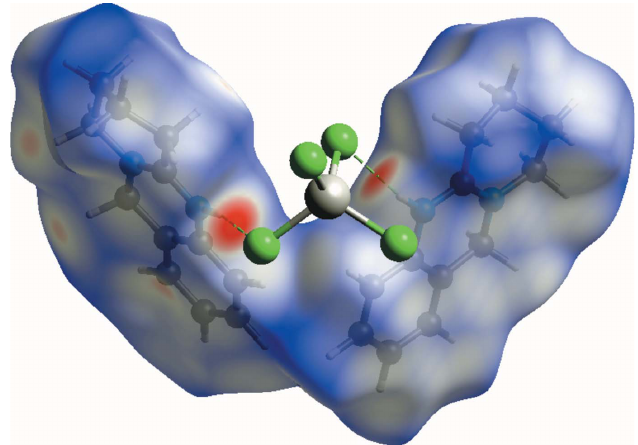
Figure 5 Three-dimensional Hirshfeld surface of the title compound mapped with d norm .